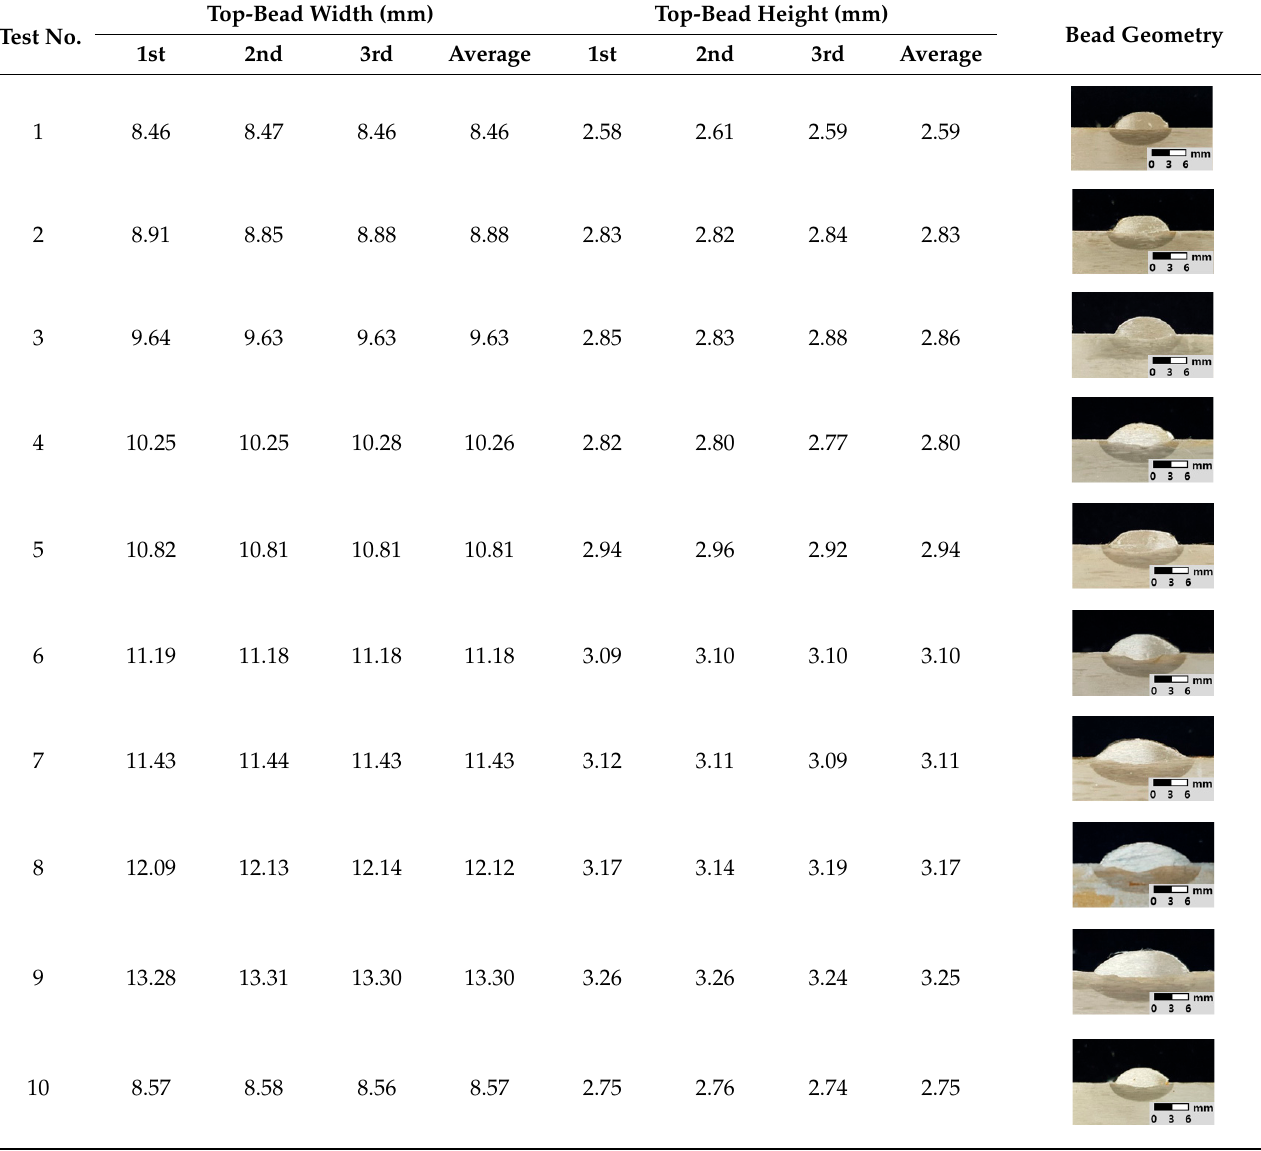
Table 5. Results of flux cored arc welding experiment [7].